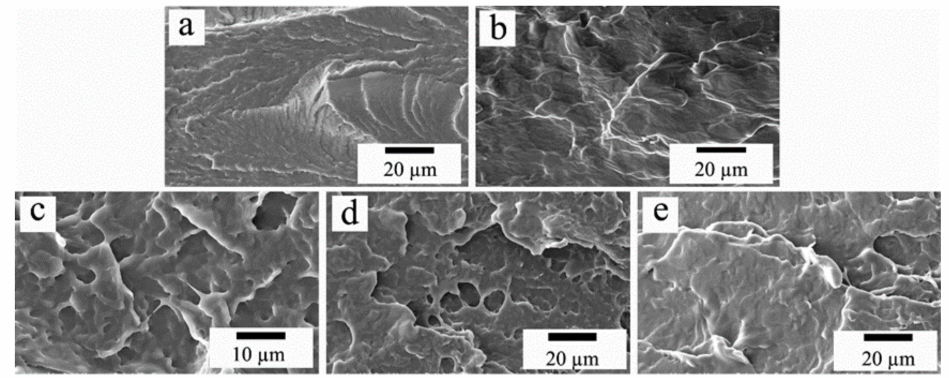
Figure 8. SEM micrographs of the tensile fracture surfaces of ( a ) CO 0% –WPU, ( b ) CO 2.50% –WPU, ( c ) CO 5.04% –WPU, ( d ) CO 7.44% –WPU, and ( e ) CO 9.66% –WPU .